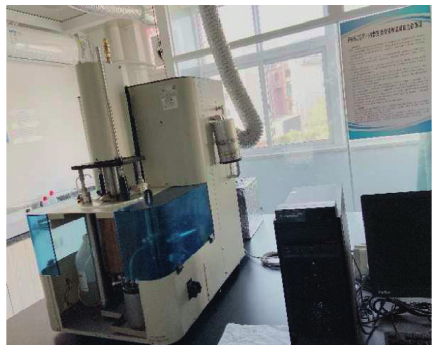
Figure 10: PoreMaster 60 GT mercury